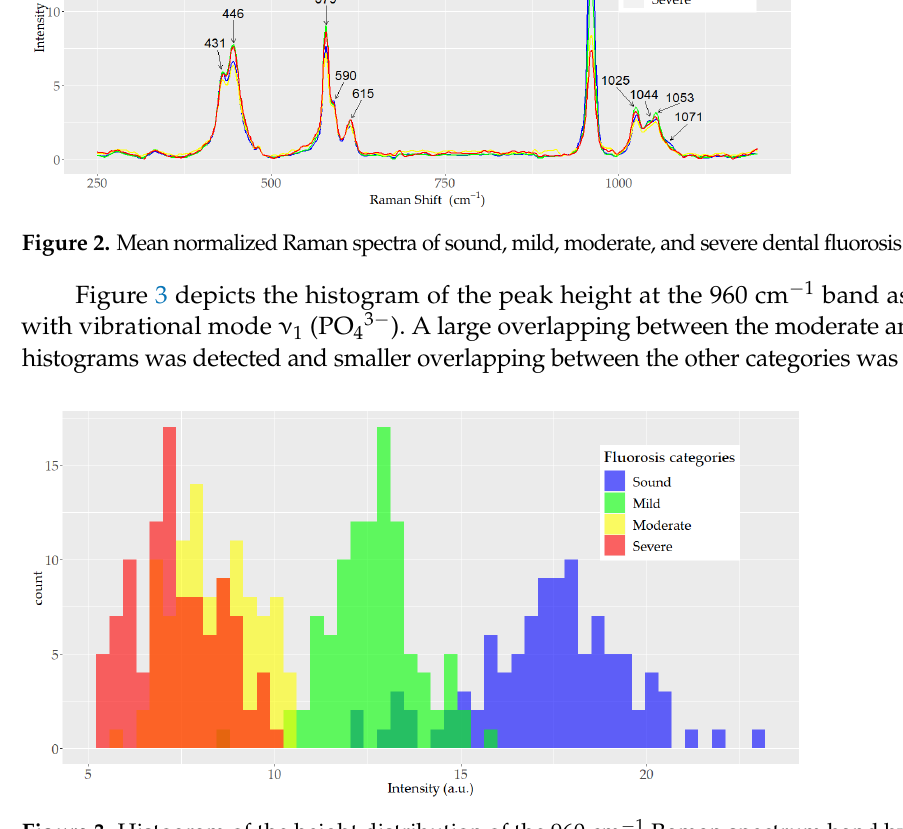
Figure 3. Histogram of the height distribution of the 960 cm − 1 Raman spectrum band by fluorosis category (100 spectra in each category).